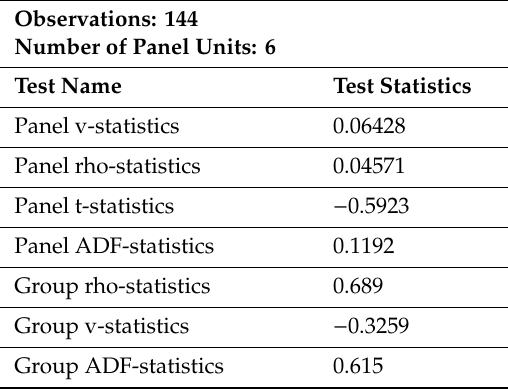
Table 5. Panel cointegration test